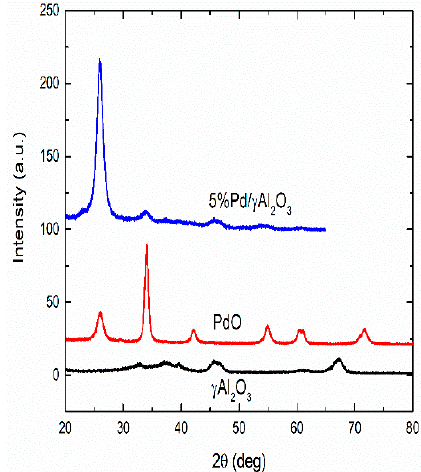
Figure 8. XRD of the catalyst, PdO, and the support.